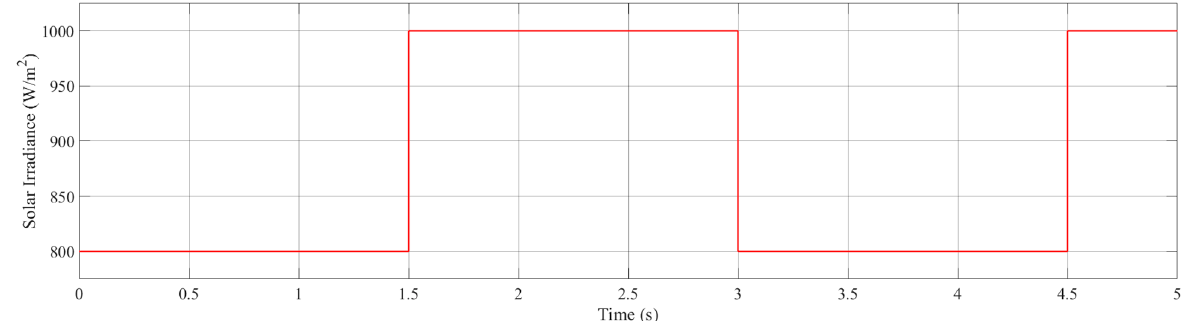
Figure 17. Solar Irradiation variations.